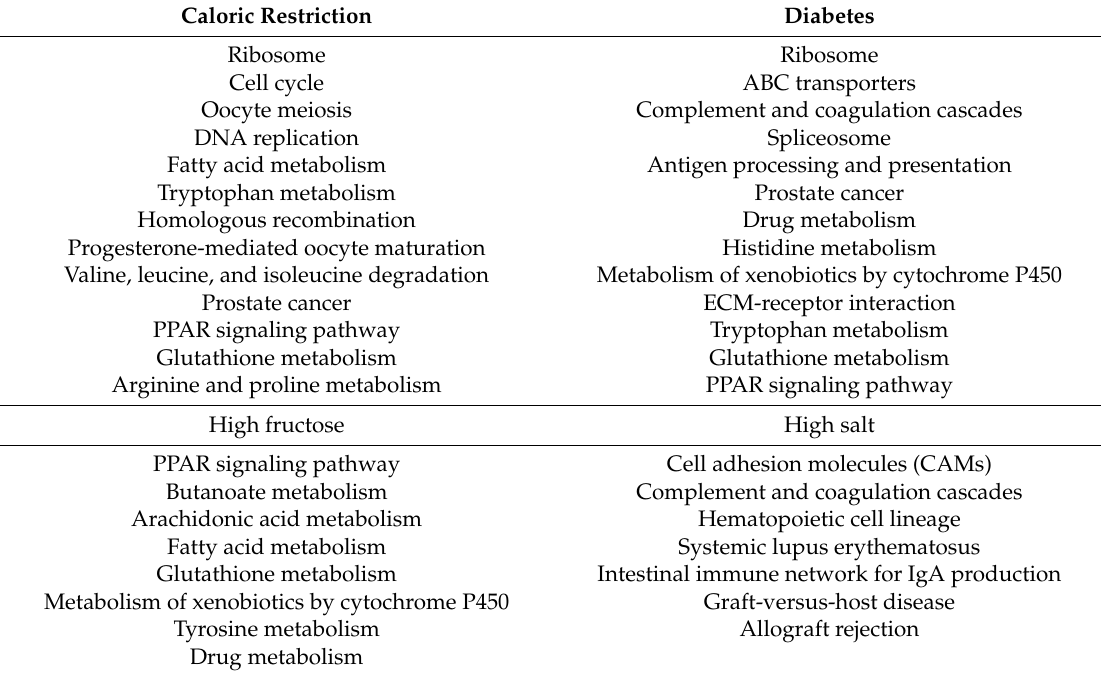
Table 2. Significantly regulated Kyoto Encyclopedia of Genes and Genomes (KEGG) pathways in the two-week-old offspring kidneys of maternal caloric restriction, diabetes, high-fructose, and high salt